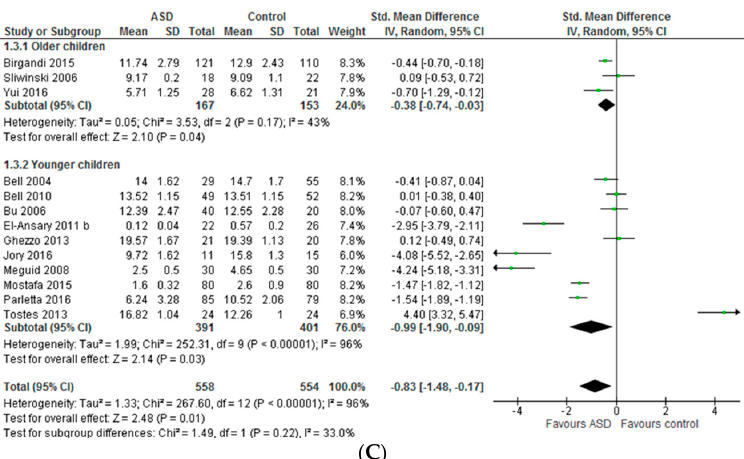
Figure 2. Forest plots of mean (95% confidence interval (CI)) weighted difference in blood levels of docosahexaenoic acid (DHA) ( A ); eicosapentaenoic acid (EPA) ( B ); and arachidonic acid (ARA) ( C ) between populations with Autism Spectrum Disorder (ASD) and typically developing controls stratified for subgroups with studies including all age groups (children, teenagers, and adults) vs. those including children only. Direction of effect (negative, lower mean in ASD group; positive, lower mean in control group; zero, no difference between groups).